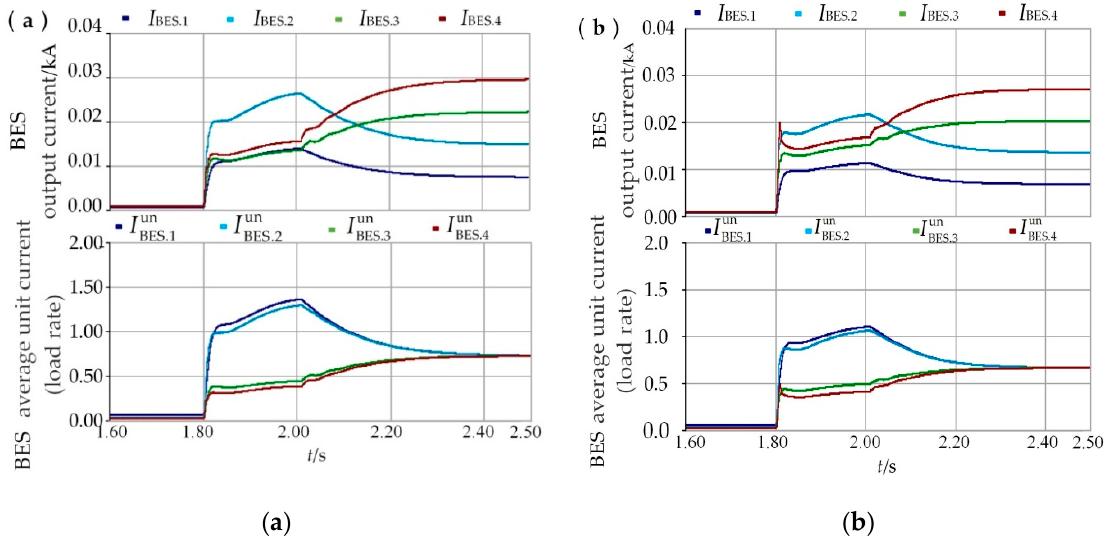
Figure 18. Simulation waveform of Situation 6. ( a ) +20% disturbance; ( b ) − 30% disturbance.